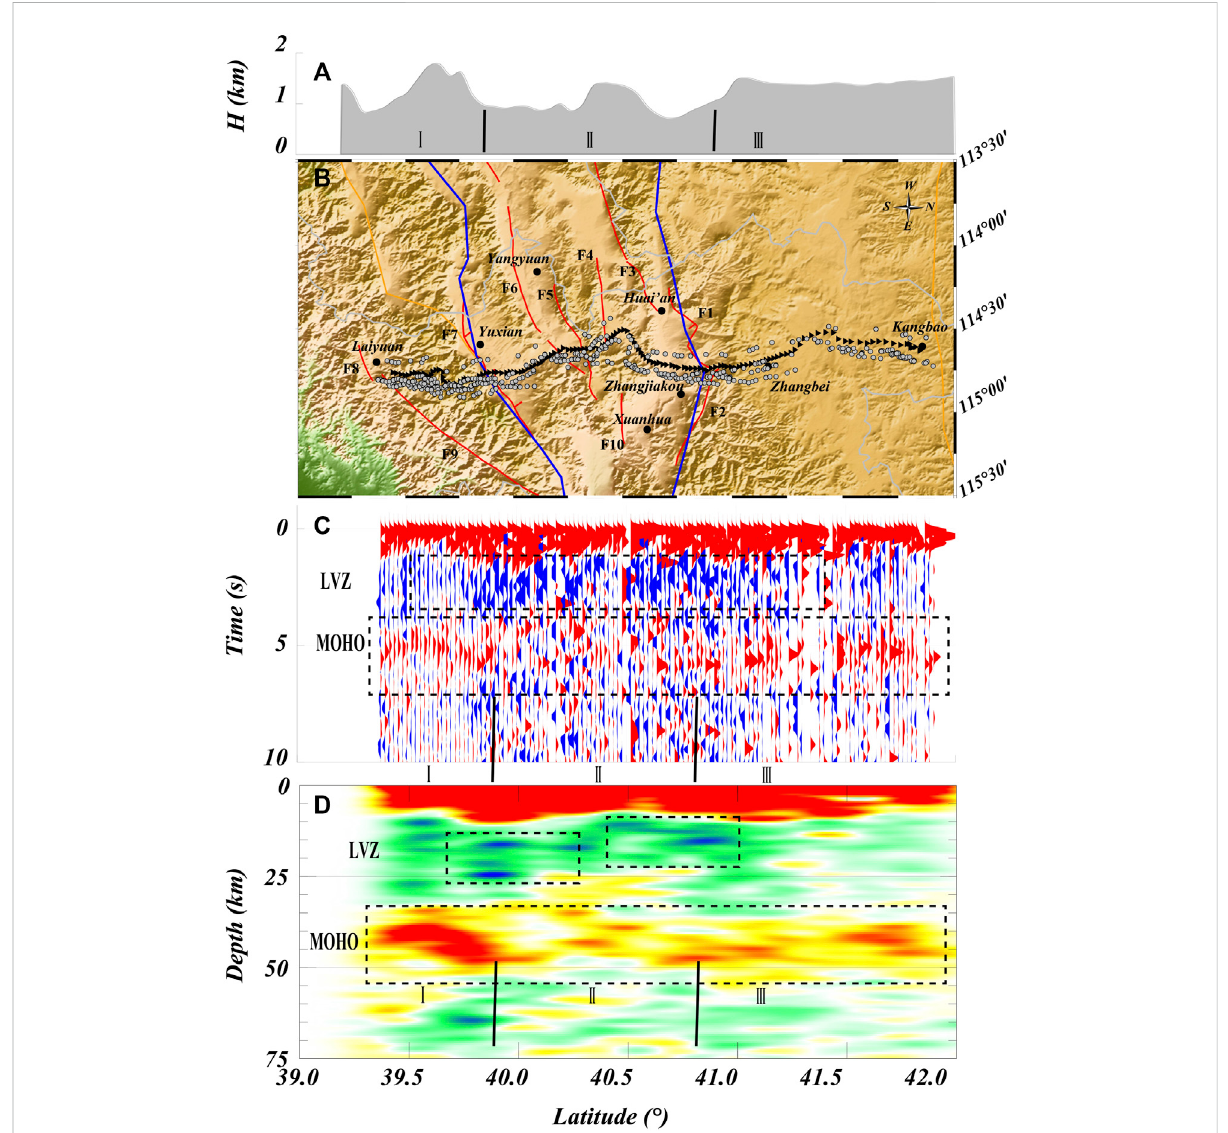
FIGURE 4 Topography, receiver function, and migration image. (A) Topographic elevation of the survey line, (B) topography and geomorphology of the study area and the distribution plan of the station, and (C) pro fi le under the survey line superimposed by the receiving function. (D) CCP result. F1- Huai ’ an – WanquanBasinnorthernmarginfault;F2-Zhangjiakoufault;F3-Tianzhen – Yanggaobasinnorthernmarginfault;F4-Huai ’ anBasinsouthern margin fault; F5-Yangyuan basin northern margin fault; F6-Liulengshan basin northern margin fault; F7-Yuguang basin southern margin